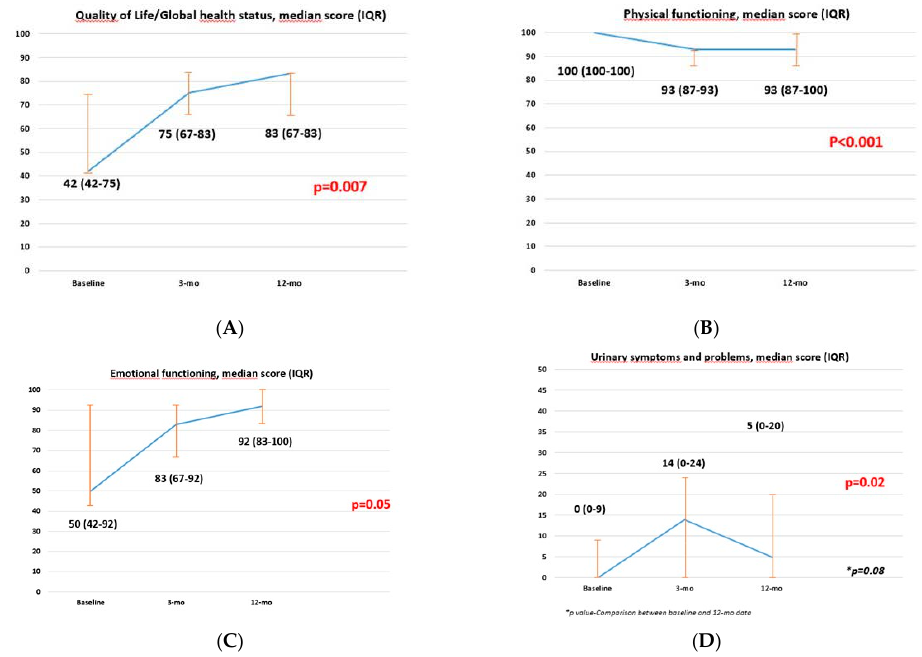
Figure 2. Graphs showing EORTC-QLQ-C30 and EORTC-QLQ-BLM30 questionnaire Items displaying statistically significance at Friedman test.